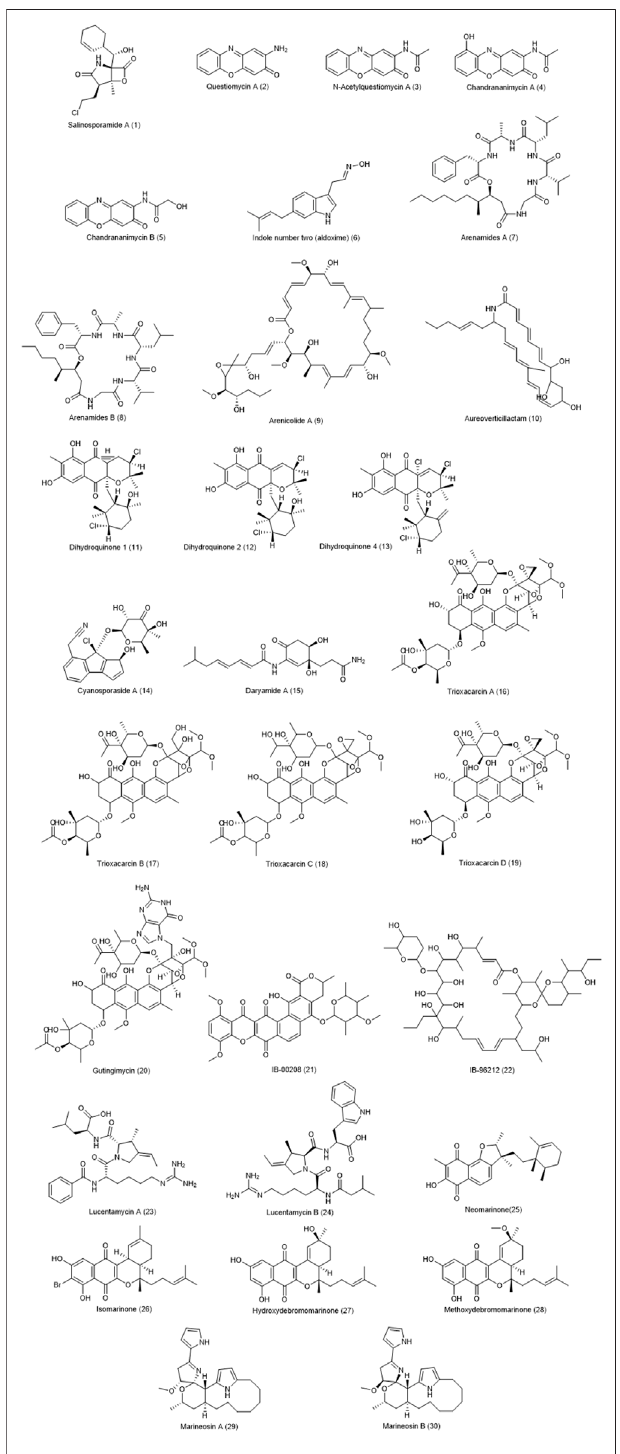
FIGURE 1 | Chemical structures of NPs 1 –